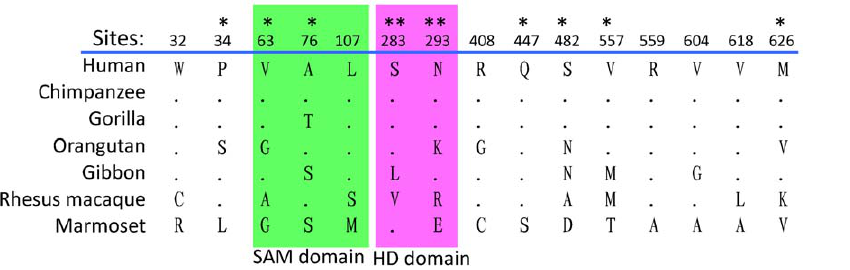
Dataset Model code lnL Estimates of parameters 2 D l PSS All 7 primate species (see Fig. 1)